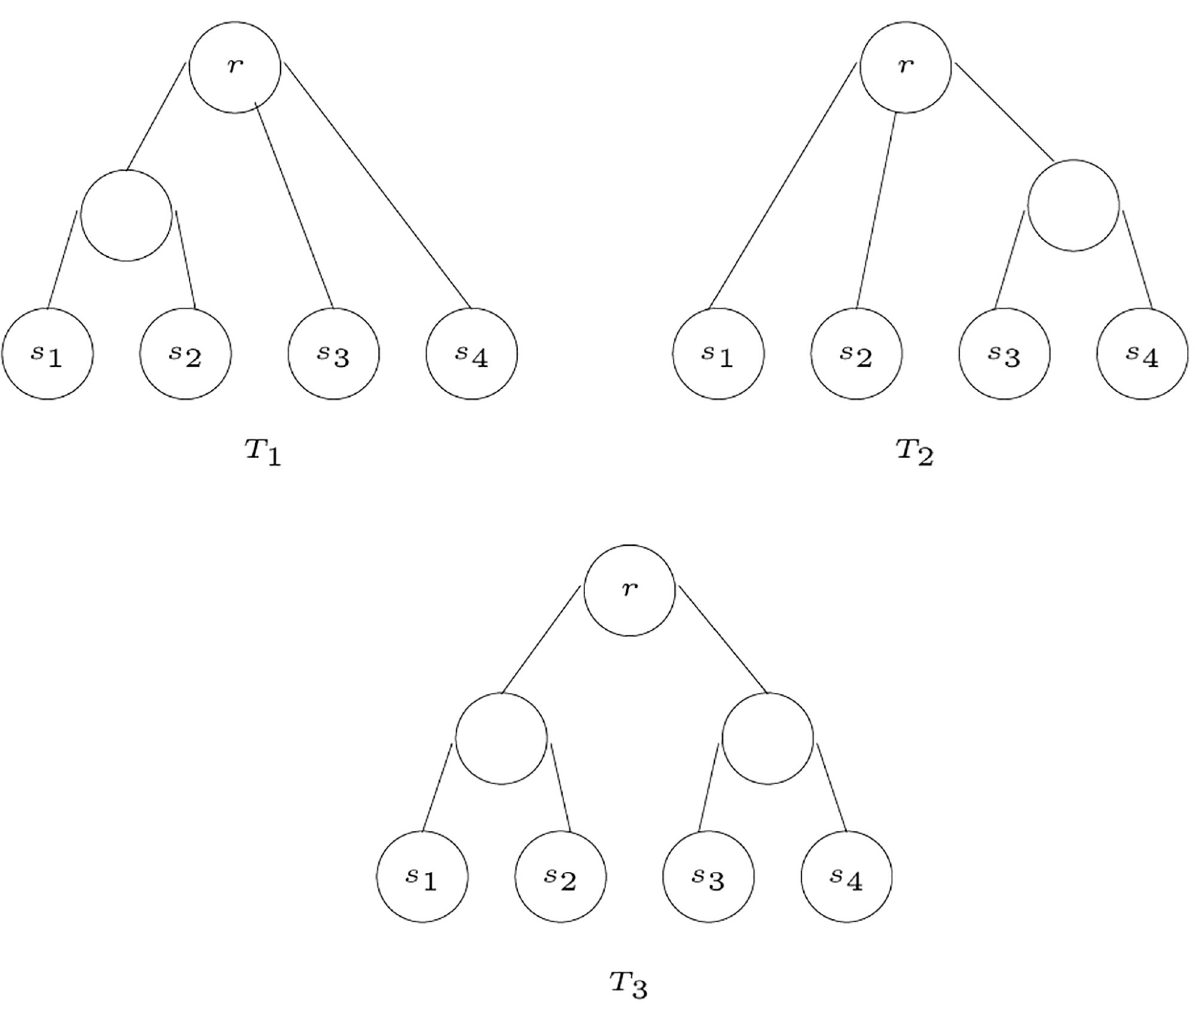
Fig 28. Refinement of T 1 and T 2 into T 3